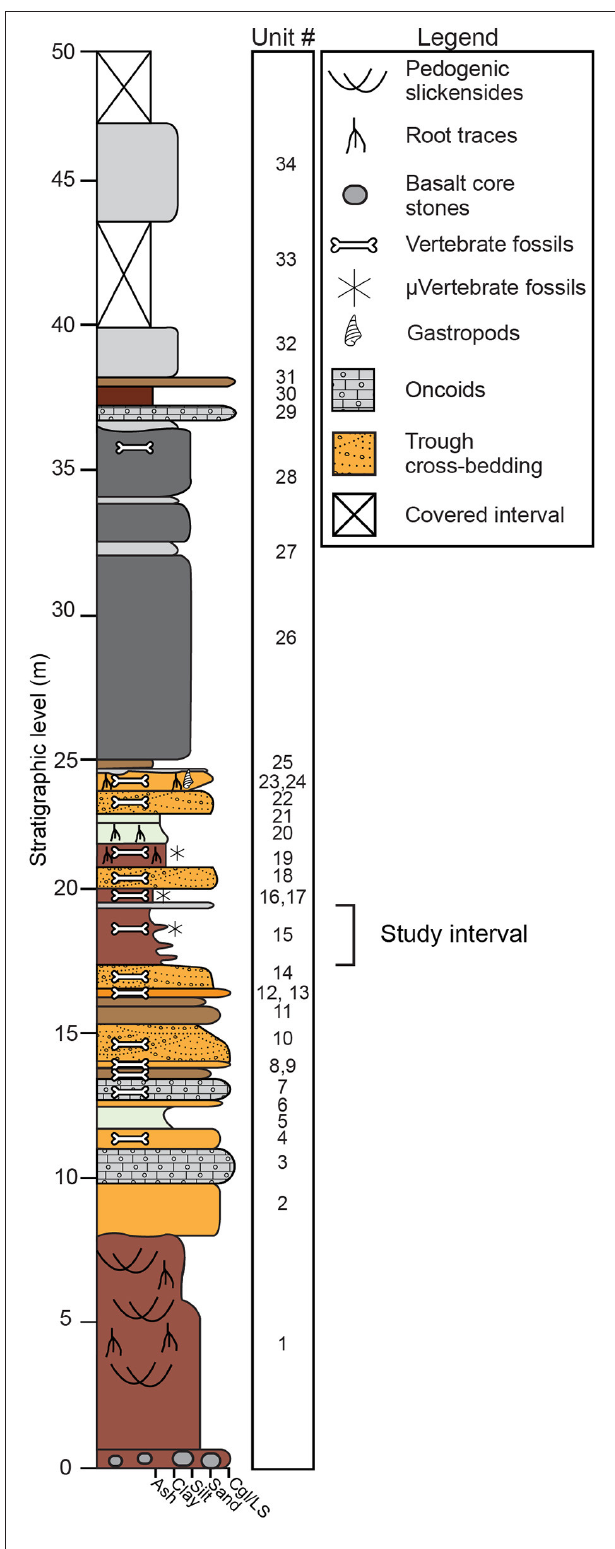
FIGURE 2 | Stratigraphic section at Ngira (after Driese et al., 2016). The current study focuses on paleosols within unit 15. Driese et al. (2016) previously examined paleosols in units 1, 19, and